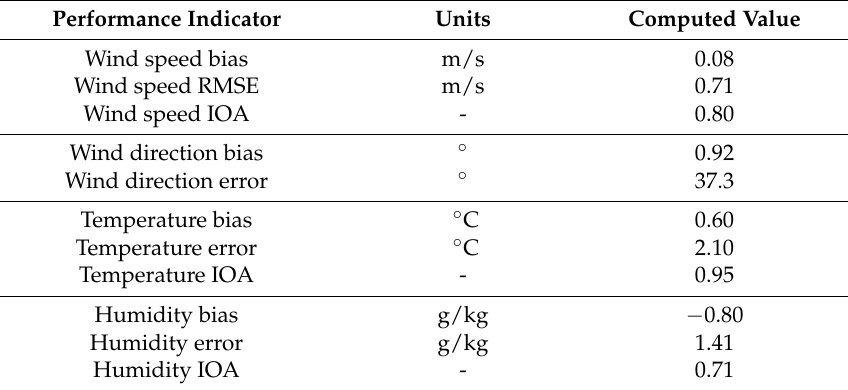
Table 1. Model performance indicators for seasonal simulations: bias, error, RMSE (root mean square error), and IOA (index of agreement). Model results were compared to observations from fixed monitor networks. Performance Indicator